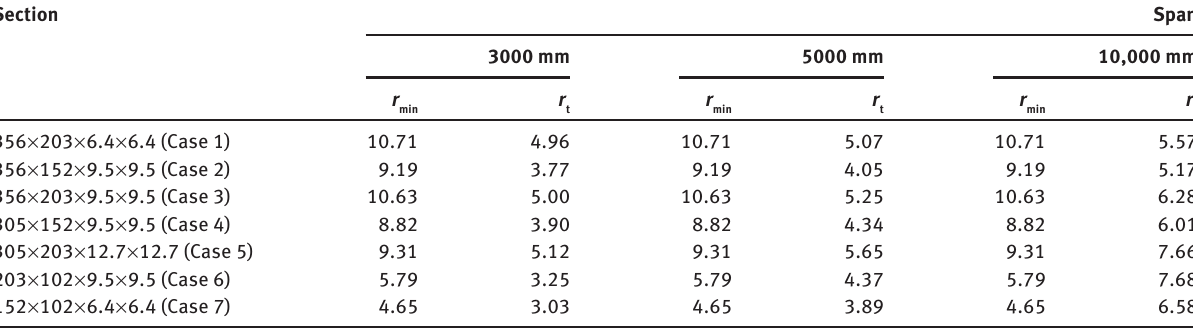
Table 4 Properties of stiffened cruciform-shaped section beams. Section